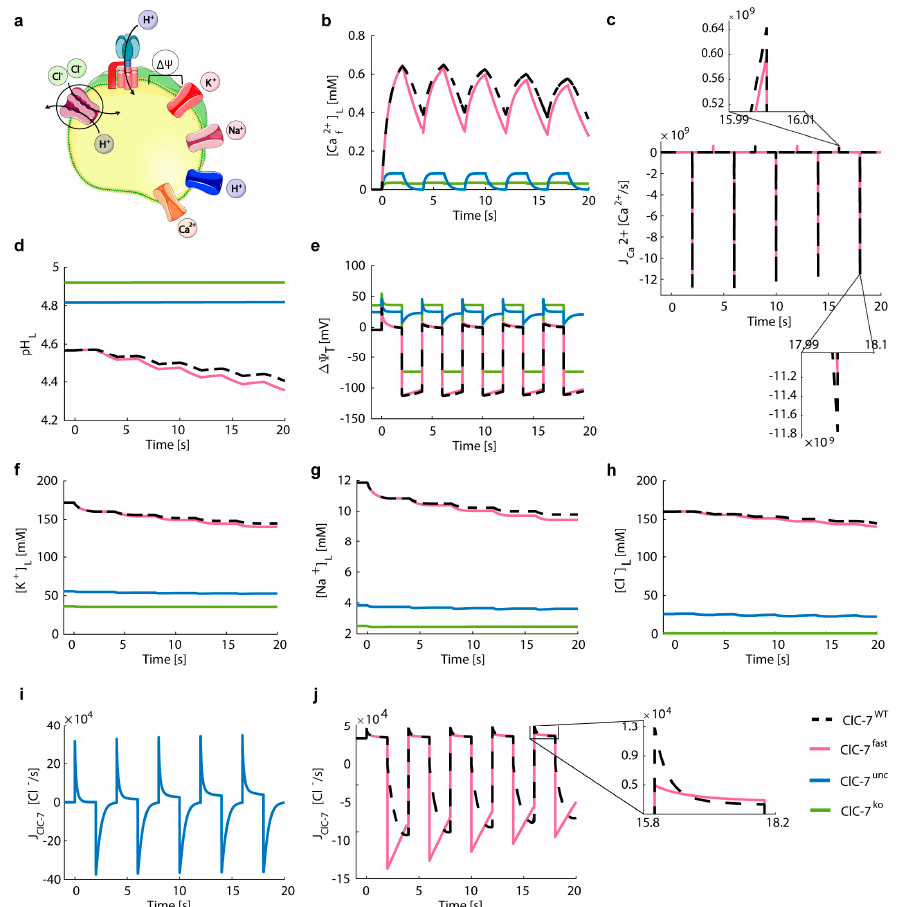
Figure 7. Ca 2 + release accompanied exclusively by ClC-7 antiporter reveals di ff erences between fast and WT scenarios. ( a ) Schematic representation of the model with ClC-7 antiporters, V-ATPases, potassium and sodium channels, proton leak, and Ca 2 + release channel. The cartoon was created using Servier Medical Art templates (https: // smart.servier.com), licensed under a Creative Commons License (https: // creativecommons.org / licenses / by / 3.0 / ). ( b – j ) Depicted for the di ff erent ClC-7 scenarios during subsequent Ca 2 + uptake and release (ClC-7 WT , dashed black line; ClC-7 fast , red; ClC-7 unc , blue; ClC-7 ko , green) are ( b ) luminal free Ca 2 + concentration, ( c ) Ca 2 + flux with a zoom to the last simulated uptake (top) and release (bottom), ( d ) luminal pH, ( e ) total membrane potential, ( f ) luminal concentrations of potassium, ( g ) sodium, and ( h ) chloride ions, as well as the turnover rates of ( i ) ClC-7 WT and ClC-7 fast , and ( j ) ClC-7 unc . The initial conditions were set to the steady state values of Figure 4 (i.e., after Ca 2 + release, Table S3). Ca 2 + uptake and release was induced every 2 s by increasing and decreasing the cytosolic Ca 2 + concentration, respectively. Ca 2 + uptake was simulated considering all the elements shown in ( a ). In order to induce a change in the activity of the ClC-7 antiporter, we simulated Ca 2 + release in the presence of only Ca 2 + channel and ClC-7